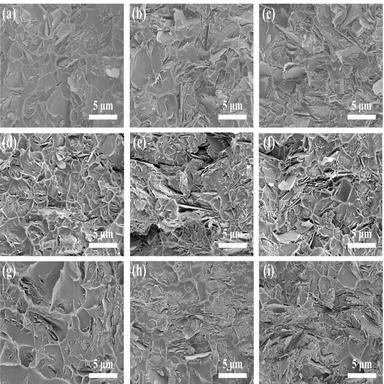
Cross-sectional morphology of different composites: (a) COC/5 wt% BNNs; (b) COC/10 wt% BNNs; (c) COC/15 wt% BNNs; (d) COC/5 wt% BNNs+7.5 wt% c-Al2O3; (e) COC/10 wt% BNNs+15 wt% c-Al2O3; (f) COC/15 wt% BNNs+22.5 wt% c-Al2O3; (g) COC/5 wt% BNNs@f-Al2O3 (7.5 wt% f-Al2O3); (h) COC/10 wt% BNNs@f-Al2O3 (15 wt% f-Al2O3); (i) COC/15 wt% BNNs@f-Al2O3 (22.5 wt% f-Al2O3).